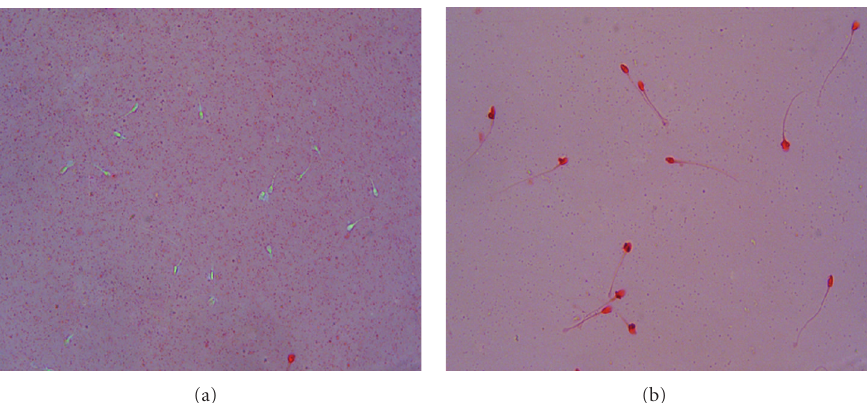
Figure 4: Eosin staining of human spermatozoa after 20s of incubation with (a) PBS, unstained live spermatozoa (b) SIF (2.1mg/mL), pink stained dead spermatozoa.